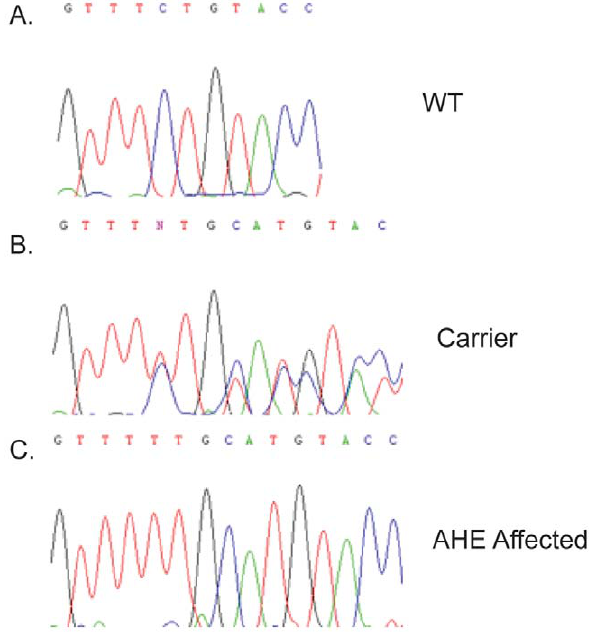
Figure 8. The relative expression levels of SLC19A3.1 in canine cerebral cortex. RT PCR from equal amounts of RNA isolated from a normal beagle and an Alaskan husky sled dog affected with AHE.